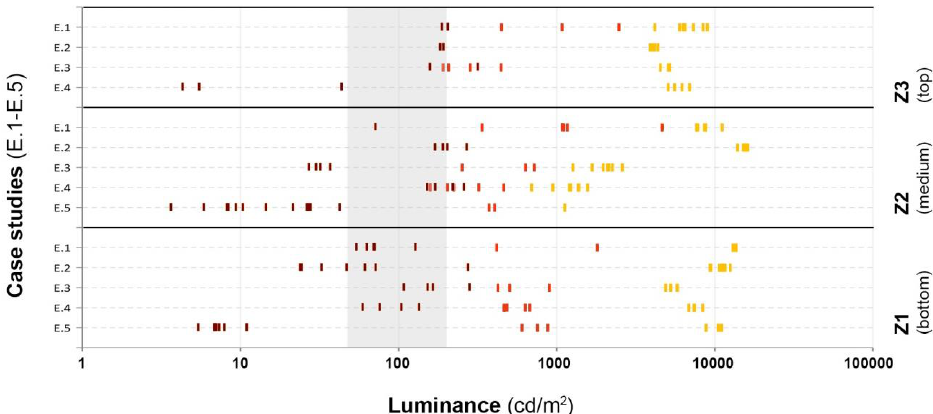
Figure 5. Graphic with the three zones of the urban scene and the luminance (cd/m 2 ) values in logarithmic scale measured in the interior and exterior of the presented case studies. Yellow: sun values outside, orange: shadow values outside, red: interior values. In grey, the most typical values of luminance in interior surfaces (50–150 cd/m 2 ).